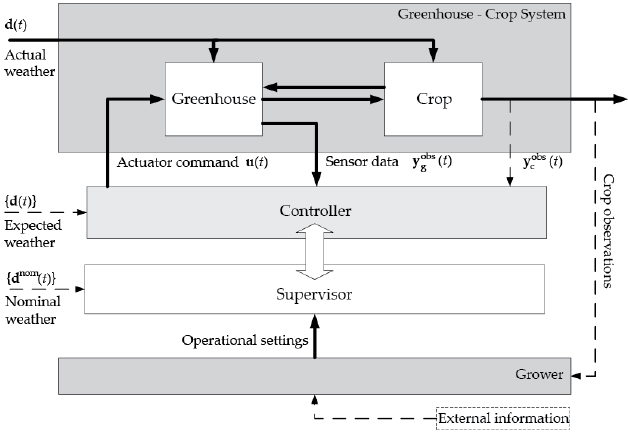
Figure 2. Hierarchical framework for greenhouse cultivation control [32].